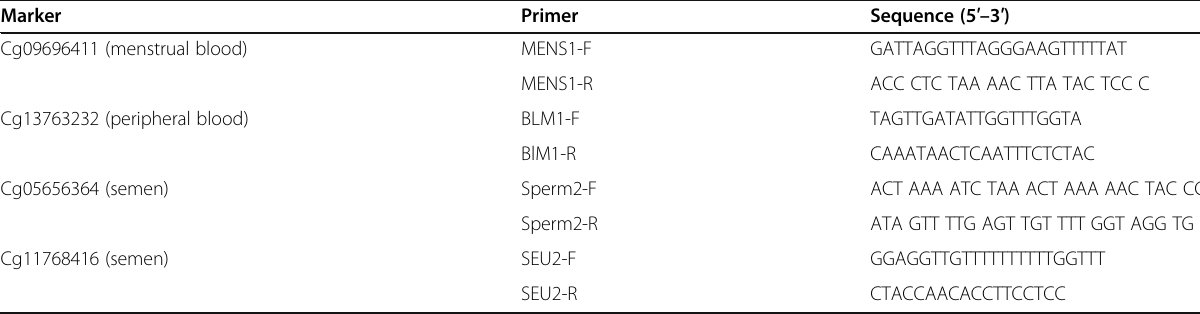
Table 1 Details of primers used for individual body fluid DNA methylation markers Marker